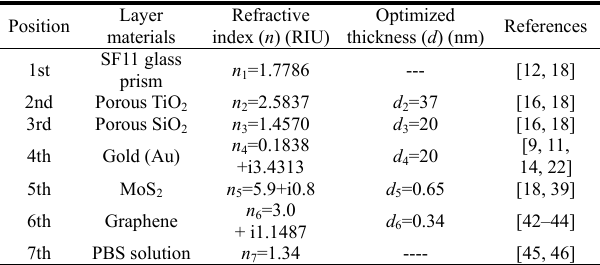
Table 1 Sensor layers’ description with the optimized material’s geometries.